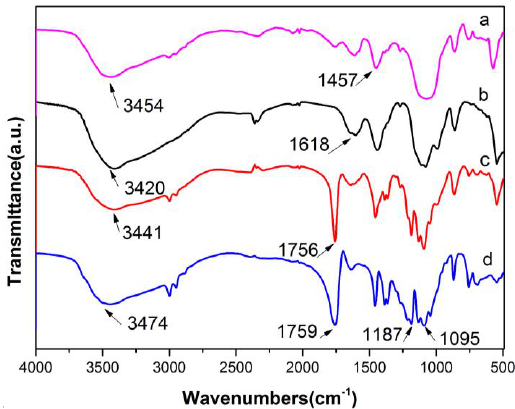
Figure 5. Fourier transform IR (FTIR) spectra of ( a ) PLLA, ( b ) GO-ZnO, ( c ) GO-Zn O /PLLA, and ( d ) GO-ZnO-PLLA.